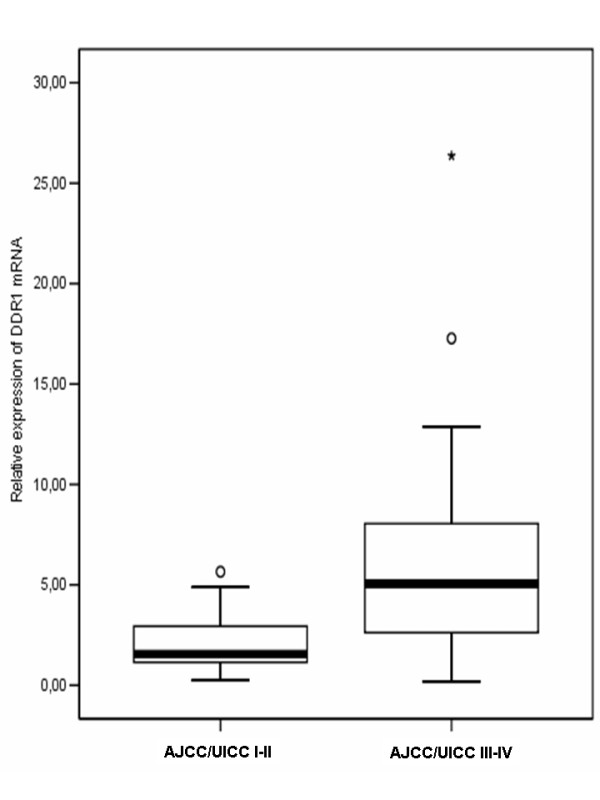
Box plots of DDR1 expression in AJCC/UICC stages of HCC. The relative expression levels of DDR1 in 23 human HCC tissues categorized according to AJCC/UICC stage I-II and AJCC/UICC stage III-IV are presented. The boxes enclose the interquartile ranges (IQRs), with the median values denoted by the horizontal lines. Circles (ο) represent outliers (values >1.5 × IQR). * p < 0.01 vs. AJCC/UICC stage I-II.